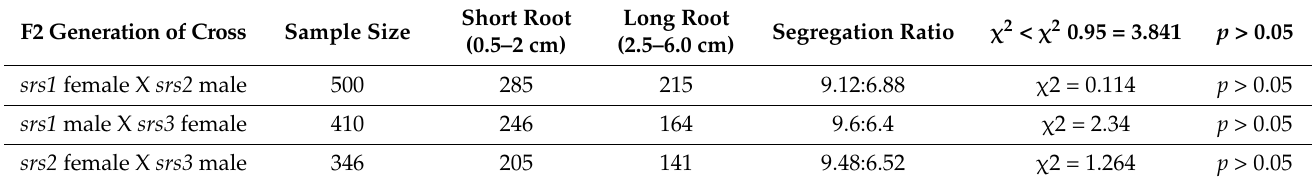
Table 4. Complementation test analysis of A. thaliana root length suppressors. F2 generation progeny of crossed suppressors was analyzed to test the short root/long root ratio. χ 2 < 3.84 is nonsignificant at 0.05 probability